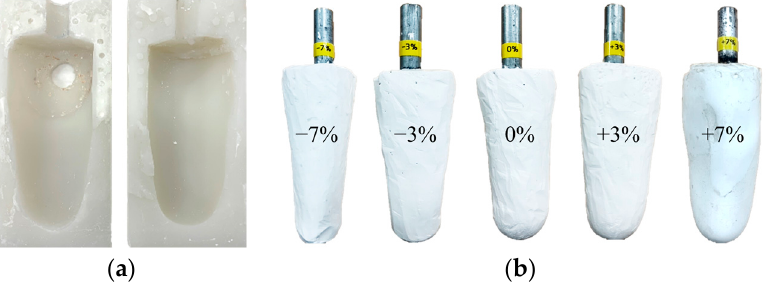
Figure 13. ( a ) The silicone mold for residual limb model; ( b ) the residual limb model with various volume changes of − 7%, − 3%, 0%, +3% and +7%.